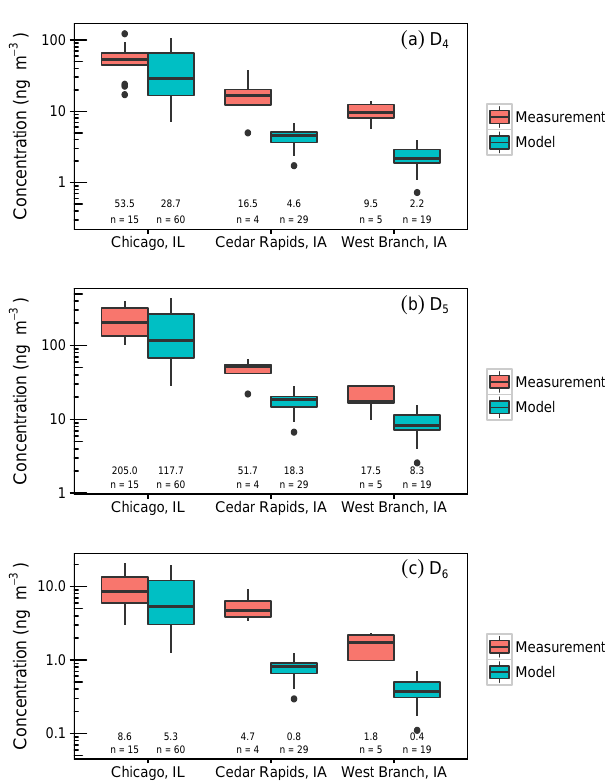
Figure 4. Model comparison to Yucuis et al. (2013). Model results from CMAQ (1–30 July simulation); measurements were conducted in 2011 from 13 to 21 August (Chicago), 29 June to 26 July (Cedar Rapids), and 6 to 22 July (West Branch), respectively. Hourly model data were averaged to 12, 24, and 36h periods, starting at typical measurement start times. Median concentrations and number of ob- servations are tabulated under the box